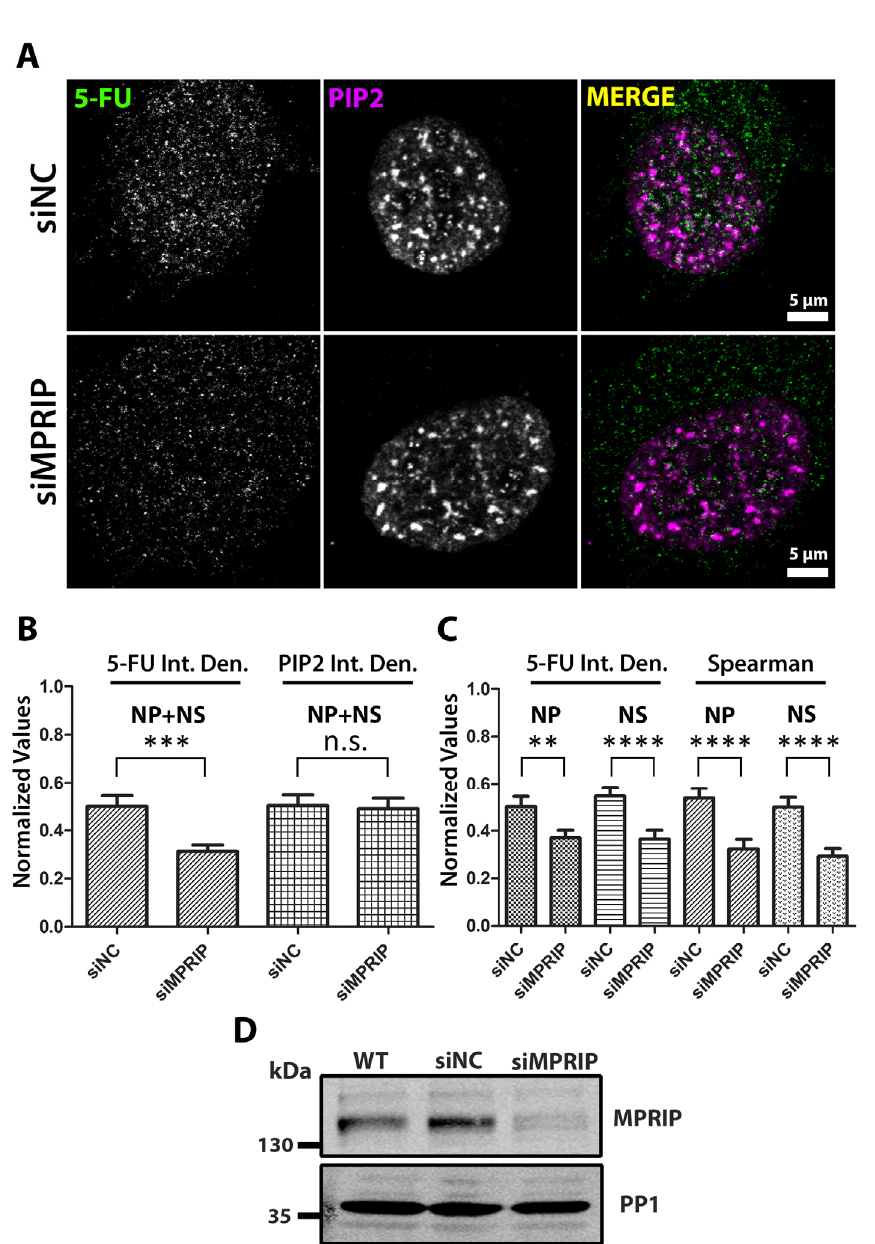
Figure 2. Nascent RNA labeling shows decreased transcriptional output in MPRIP depleted cells. ( A ) Indirect immunofluorescence experiment on U2OS cells showing the 5-FU and PIP2 labeling in control ( siNC —small interfering Negative Control RNAs) and MPRIP depleted ( siMPRIP —small interfering MPRIP RNAs) nuclei. Scale bars represent 5 µ m. ( B ) The integrated densities ( Int. Den. ) of 5-FU and PIP2 signals in siNC and siMPRIP nuclei are normalized and represented as a column chart. ( C ) The Spearman’s coefficients and the integrated densities of 5-FU signals are analyzed at different PIP2-rich nuclear compartments and the normalized values are shown in the column chart. ( D ) The total cell extracts of Wild-Type ( WT ), siNC and siMPRIP were analyzed by WB to confirm the depletion of MPRIP in U2OS cells. The membranes are blotted with anti-MPRIP specific antibody and with anti-PP1 specific antibody as a loading control. n = 3. NP —Nucleoplasmic, NS —Nuclear Speckles. n.s. —Not significant. The double asterisks “**” correspond to a significance level of p ≤ 0.01, the triple asterisks “***” correspond to a significance level of p ≤ 0.001, and the quadruple asterisks “****” correspond to a significance level of p ≤ 0.0001. n = 3, 10